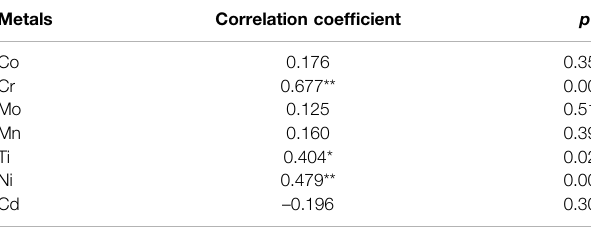
TABLE3| PearsoncorrelationanalysisbetweenmetalconcentrationandTUNEL- positive levels in oral mucosa.